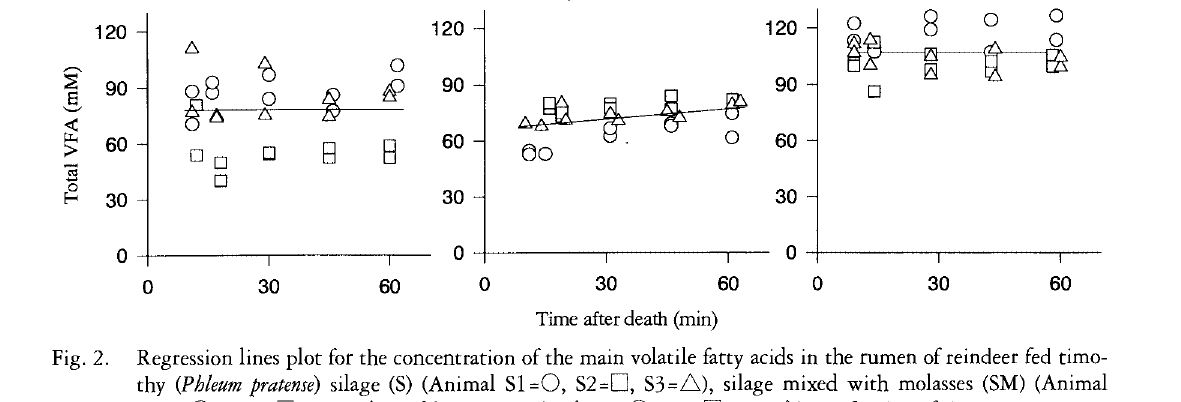
Table 4. Body mass at the start and at the end of the feeding experimenr, carcass weight, weight of total gastrointesti nal (GI) tract and the reticulo-rumen in reindeer fed regrowth timothy (Phleum pratense) silage (S), silage mixed with molasses (SM) and hay